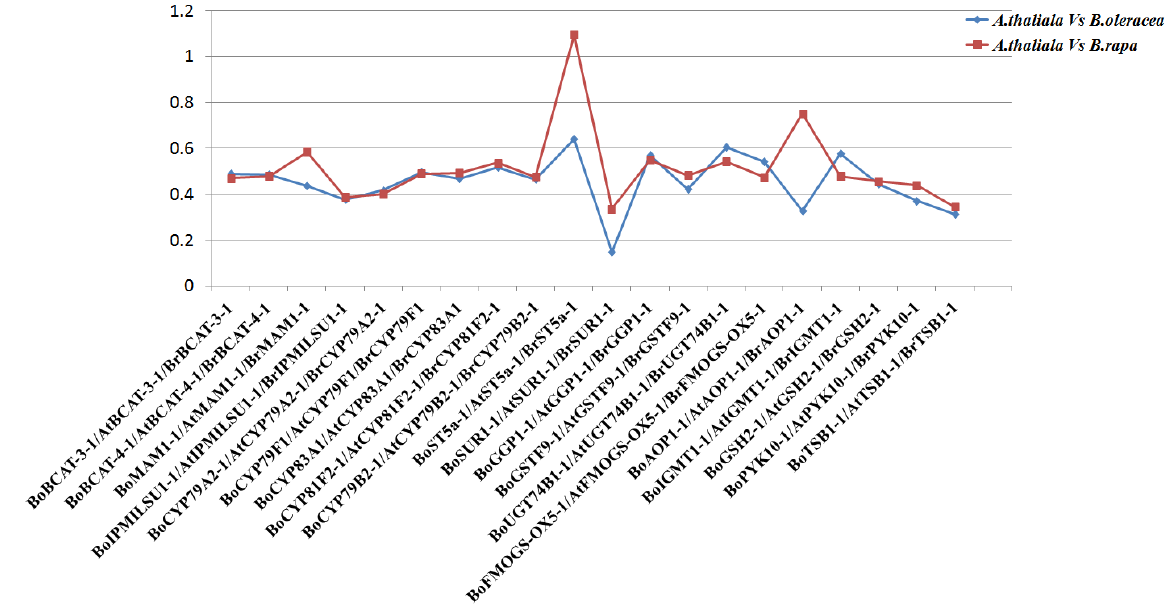
Figure 4. Scatter plot of Ka/Ks values of orthologous gene pairs for GBGs among Arabidopsis thaliana , Brassica oleracea and Brassica rapa . Brassica oleracea and Brassica rapa